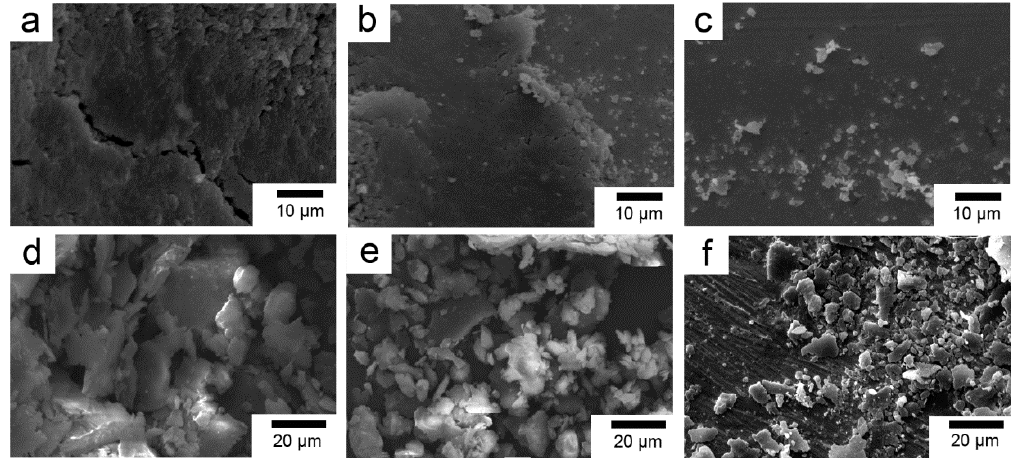
Figure 18. SEM photographs of the counterface and wear debris corresponding to the ( a , d ) PBO-Pre / PI, ( b , e ) PBO-APTES / PI, and ( c , f ) PBO-La / PI composites.